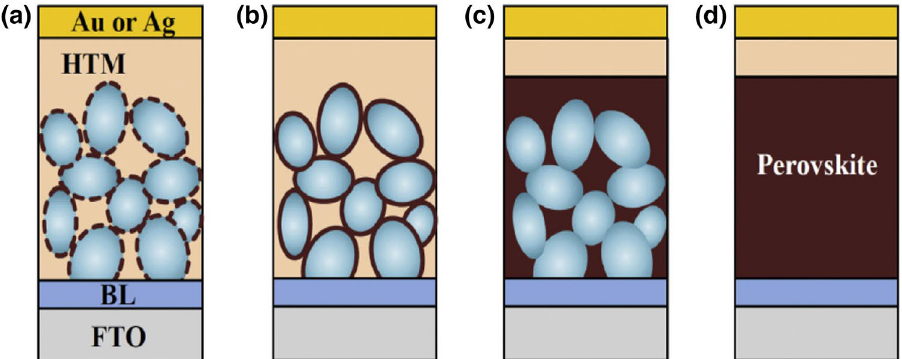
Fig. 1 Incorporation of perovs- kite material from the earliest cell design ( a DSSC) to existing design ( d Perovskite solar cell)